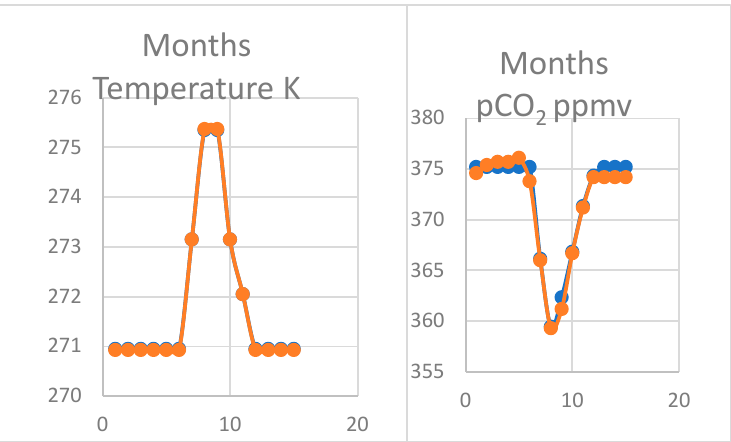
Figure 6. Estimated variation in p CO 2 ( right ) with temperature ( left ) January to December at Point Barrow, Alaska showing a plateau in winter months falling in summer, consistent with modelled reduced solubility shown in Supplementary Materials. Thus, CaCO 3 is predicted to be dissolved when seawater is colder from November to June.